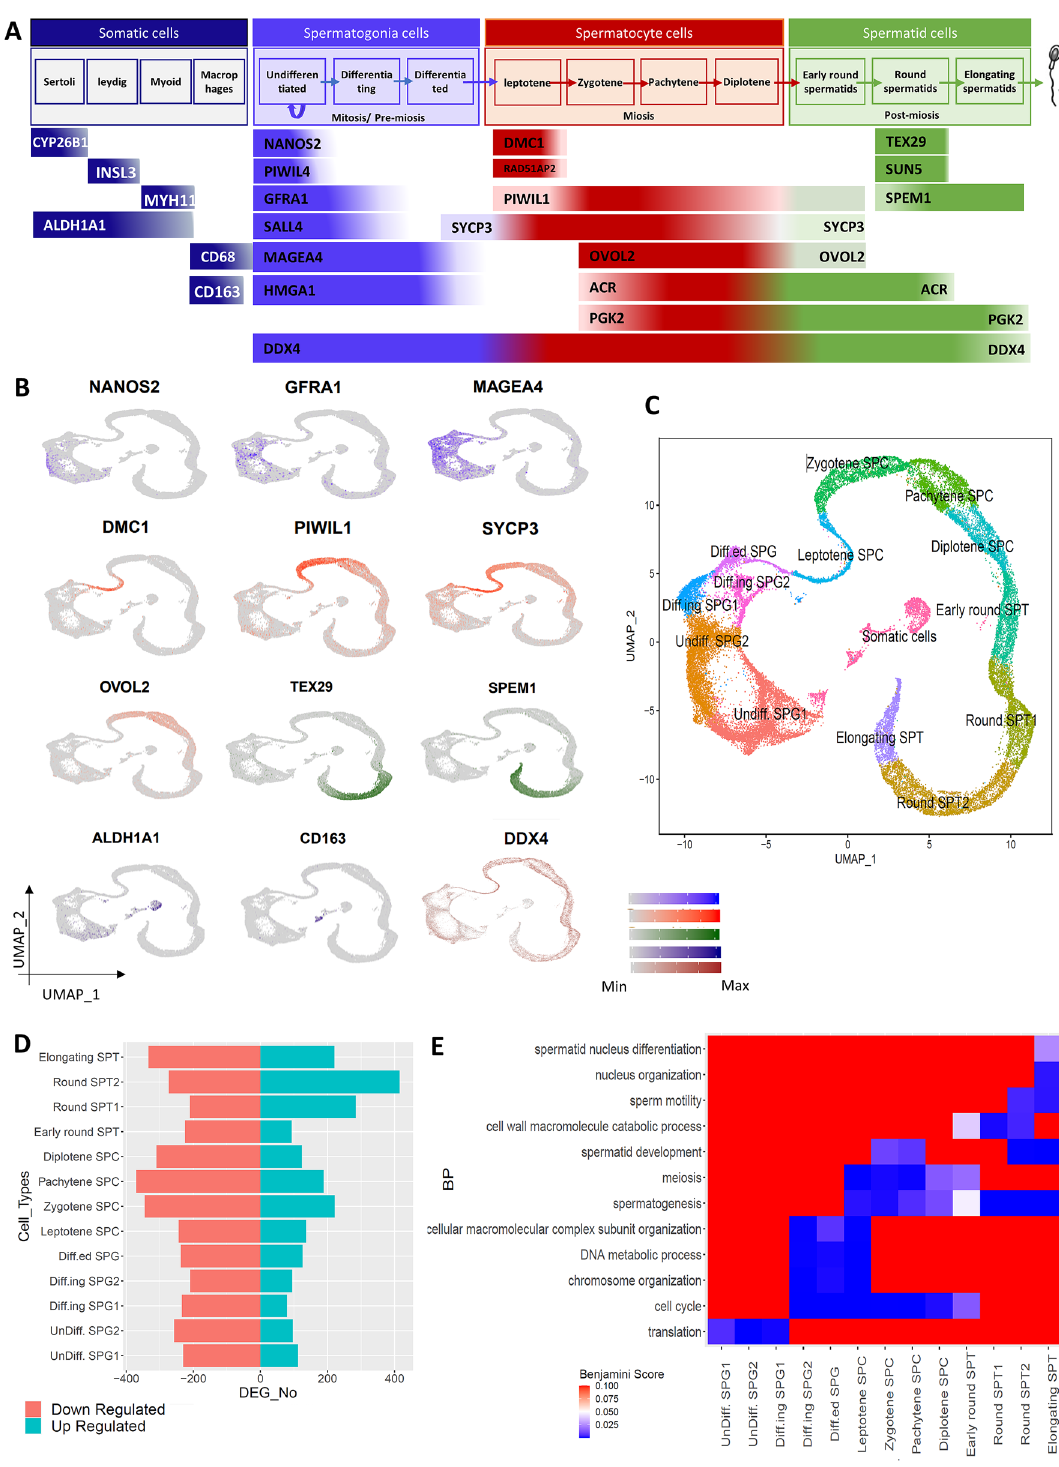
Figure 2. Cell type assignment of clusters. ( A ) Gene markers of testicular cells were categorized based on different somatic, spermatogonia, spermatocyte, and spermatid cells, ( B ) gene expression patterns of these markers on the UMAP space which were colored based on the A part categorization, ( C ) cell type assignment of clusters based on gene markers expression patterns, ( D ) the number of up- and down-regulated genes in different germ cell types, ( E ) the biological processes enrichment for up-regulated genes of different germ cell type